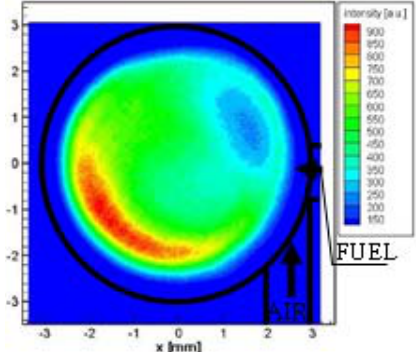
Figure 4. EDC: Temperature, t = 0.05 s. The chamber wall is the black